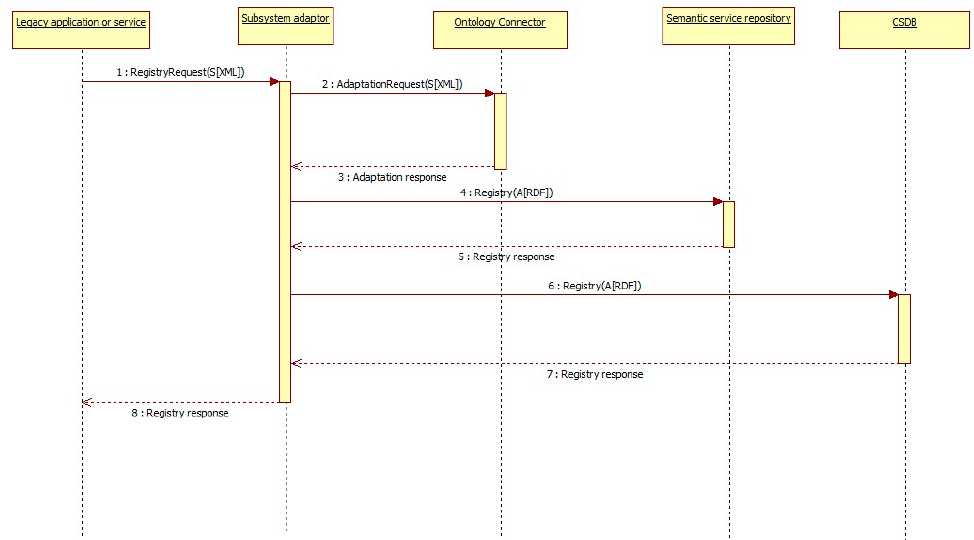
Figure 12. Service registration sequence diagram.